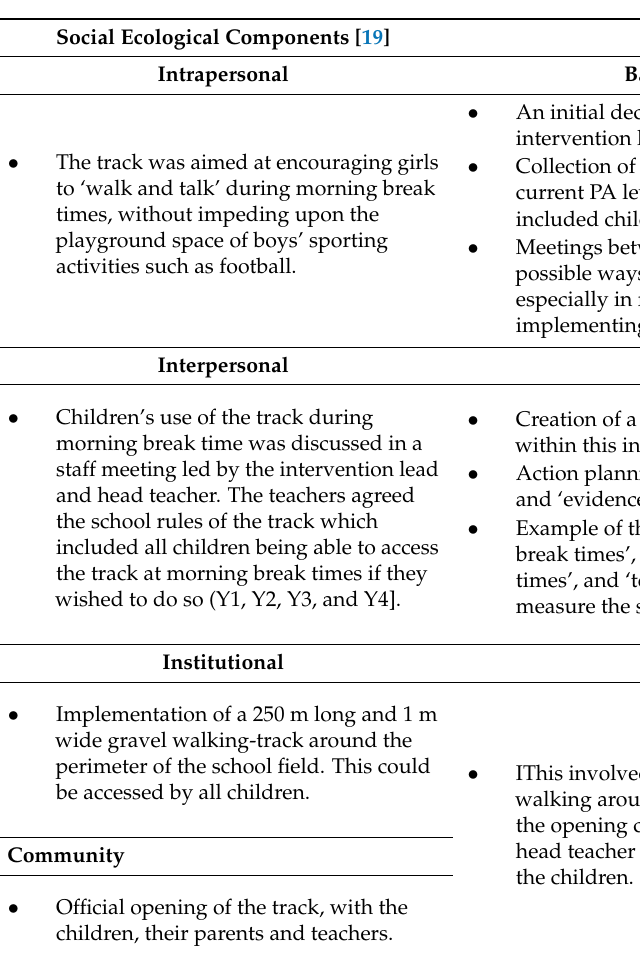
Table 1. Walking-track intervention model theoretical